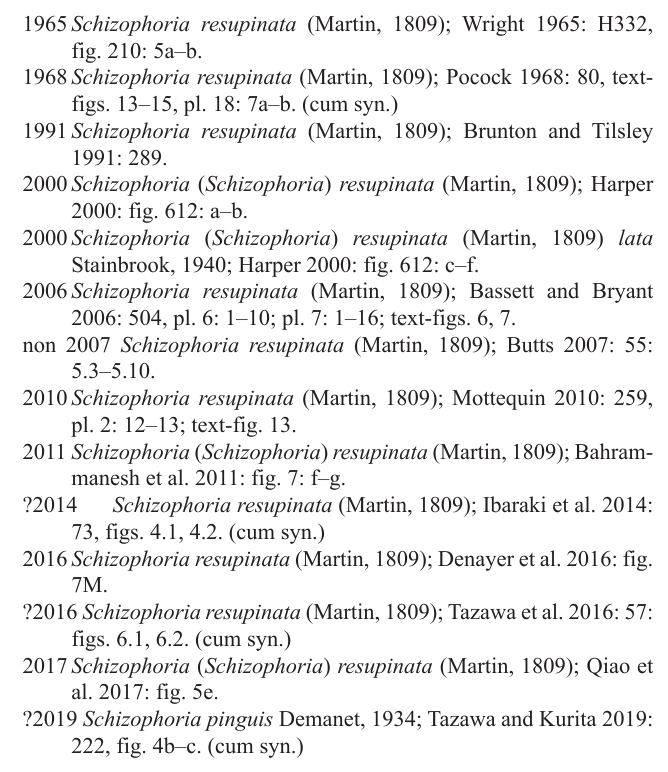
figs. 6.1, 6.2. (cum